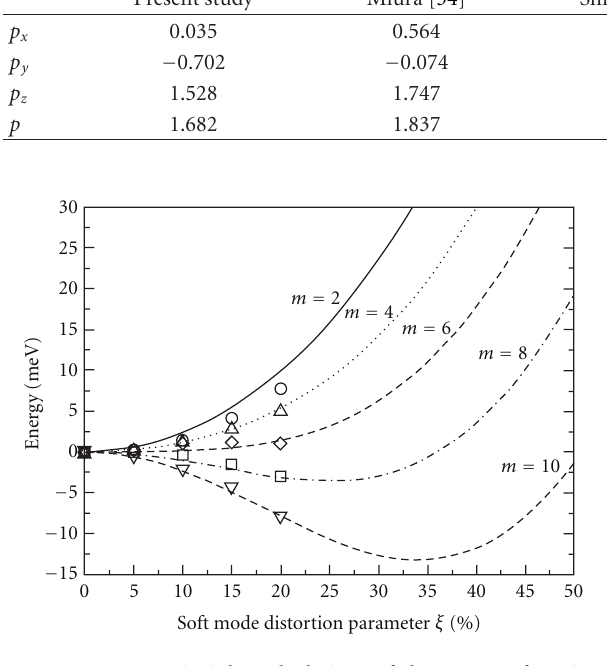
Figure 10: First-principles calculations of the energy of BaTiO 3 ferroelectric films with m unit cells as a function of the soft-mode distortion ξ [29].